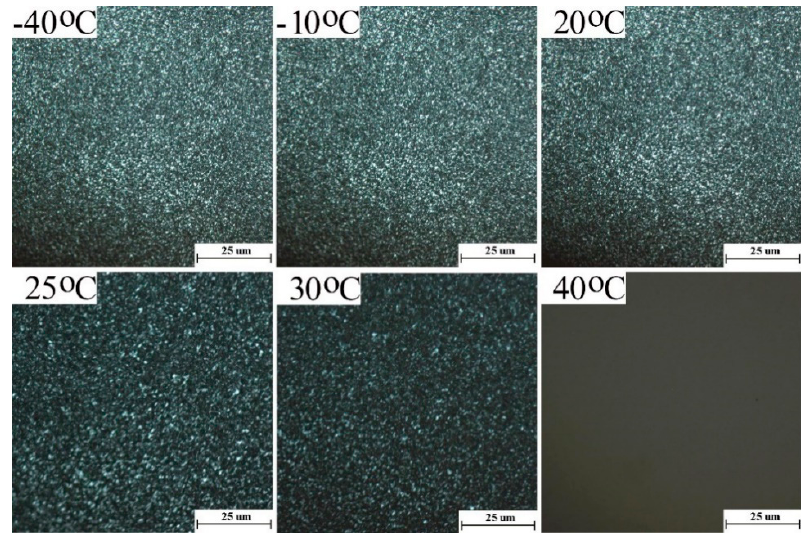
Figure 2. Polarizing optical microscopy (POM) snapshots of elastomer S0 at different temperatures.